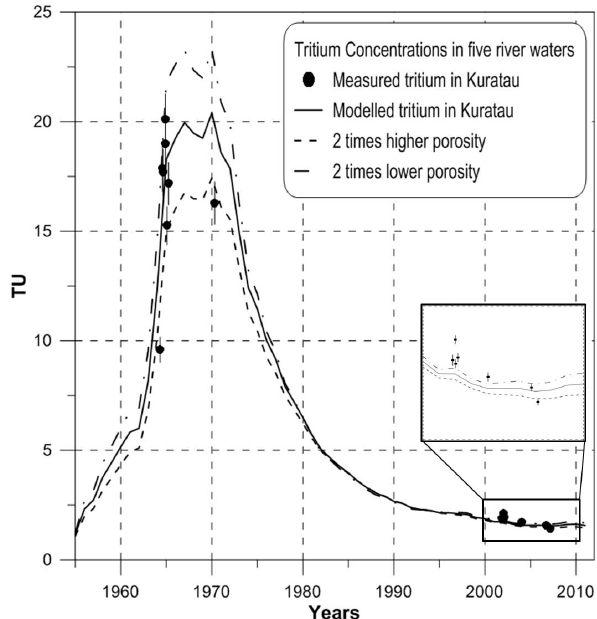
Fig. 3. Measured and simulated tritium concentrations for the Ku- ratau River waters with the tritium-calibrated MT3MS model. The dashed and dashed-dotted lines show the tritium outputs for two times lower and higher porosities of Whakamaru unit a (W5a), the Whakamaru unit b (W5b) and the Pakaumanu unit (P7) compared to the calibrated